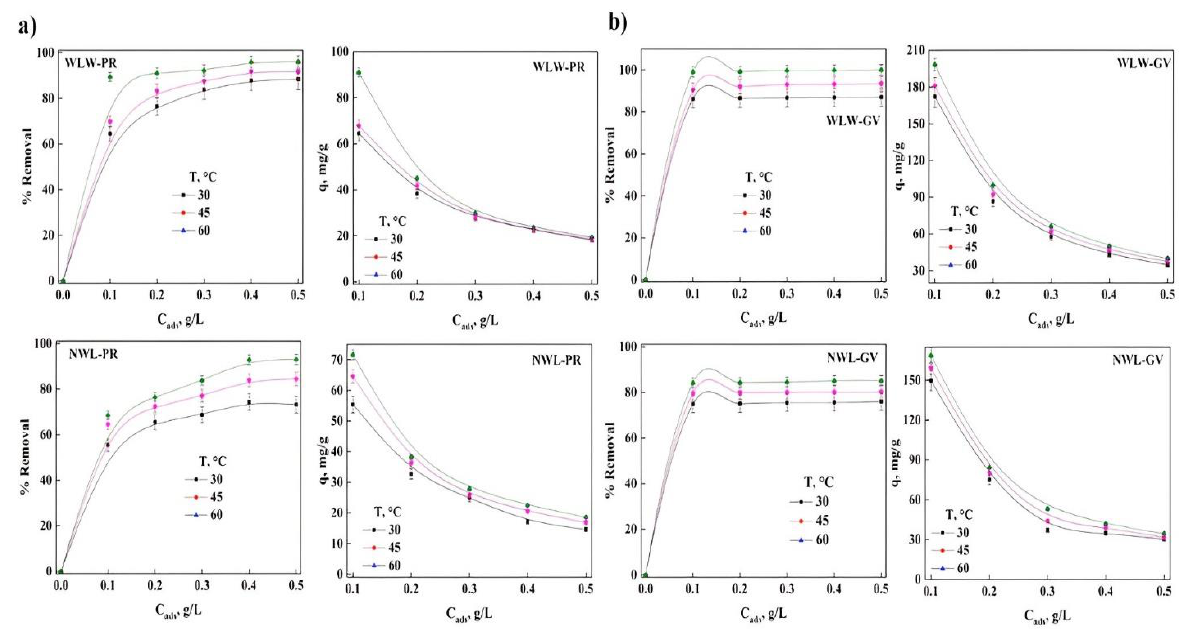
Figure 6. Effect of adsorbent concentration on removal percentage and adsorption capacity: ( a ) PR and ( b ) GV.